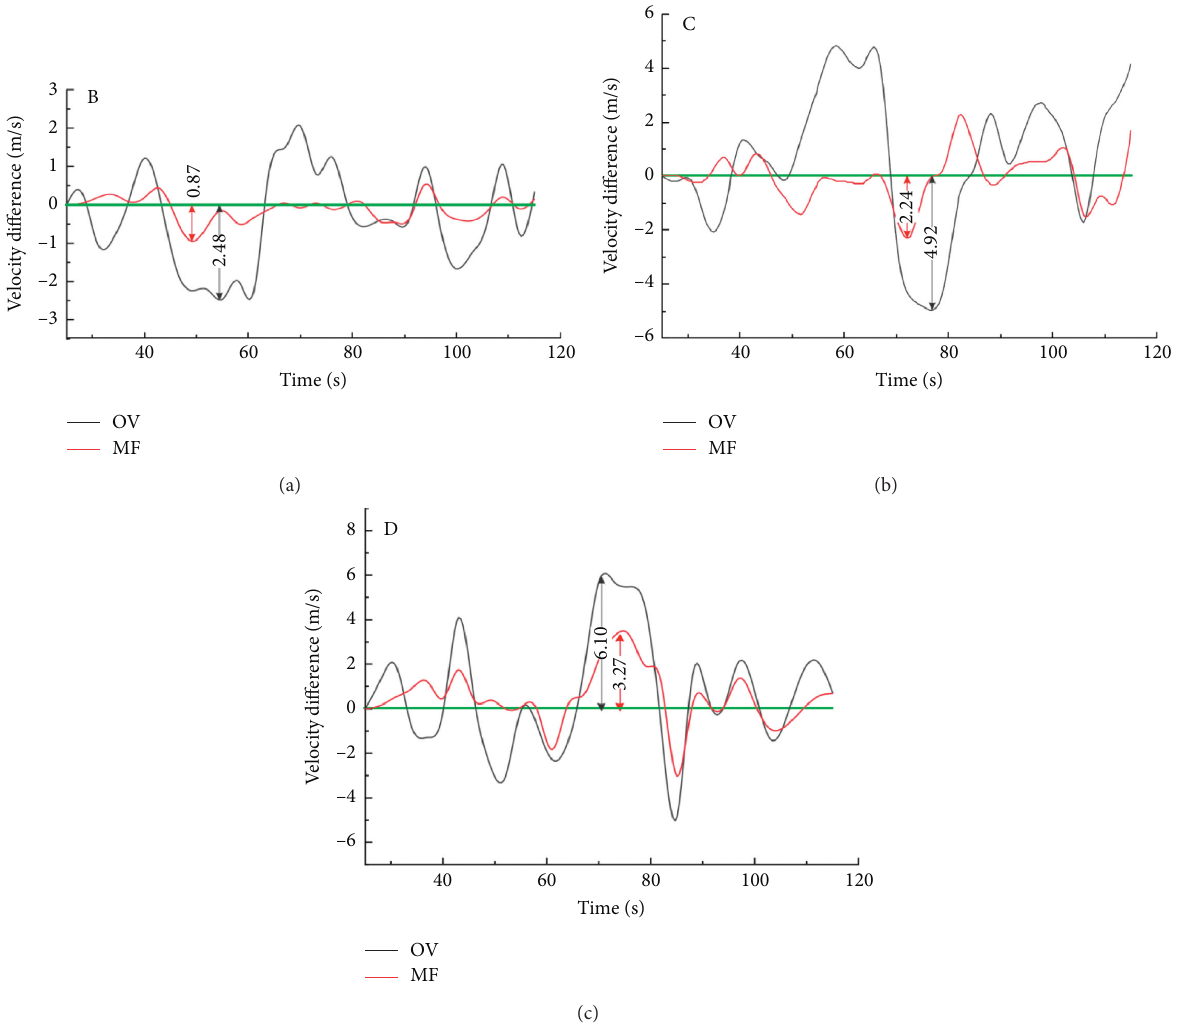
Figure 12: Velocity error curves of vehicles B, C, and D.